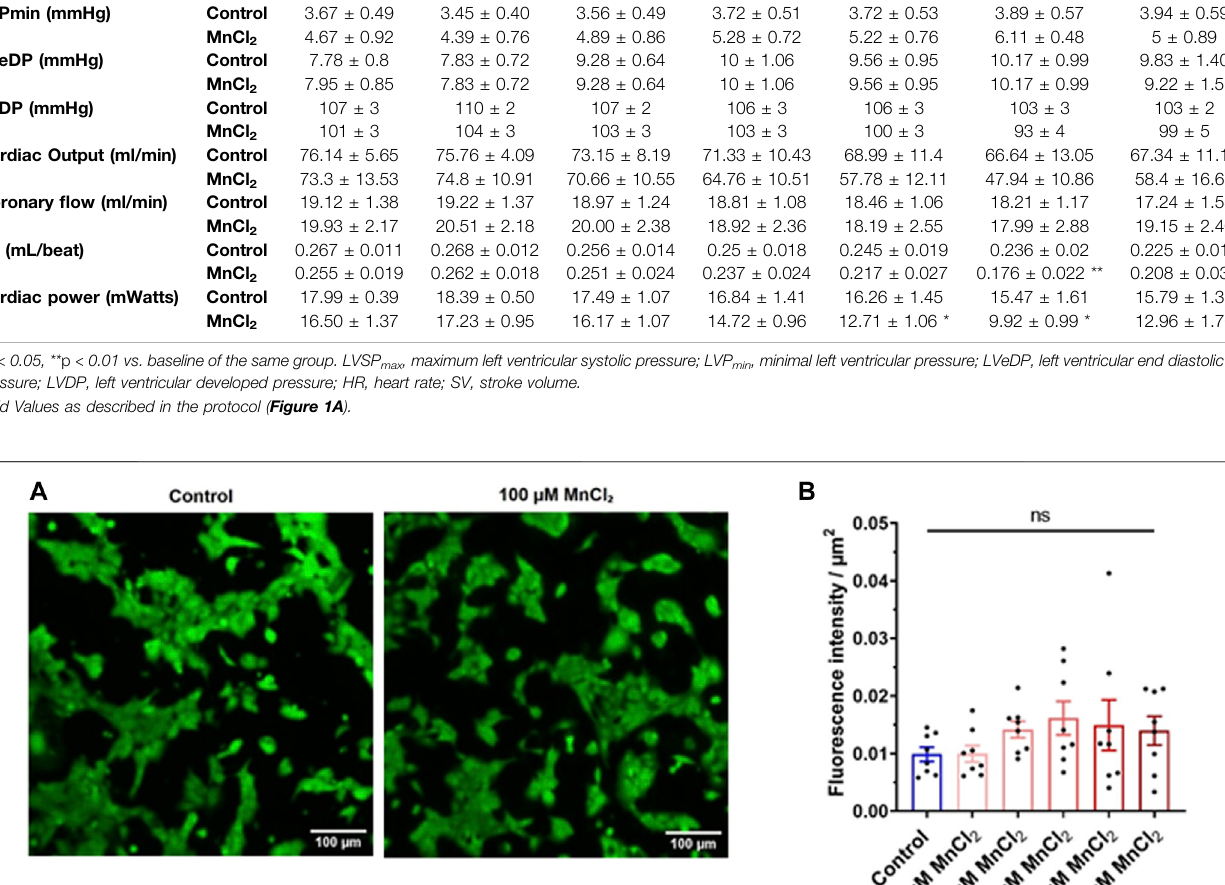
shows representative images of HL-1 under control condition and bathed with 100 µM MnCl 2 . Mean data indicates that micromolar concentration of MnCl 2 did not affect viability of HL-1 cardiac myocytes.